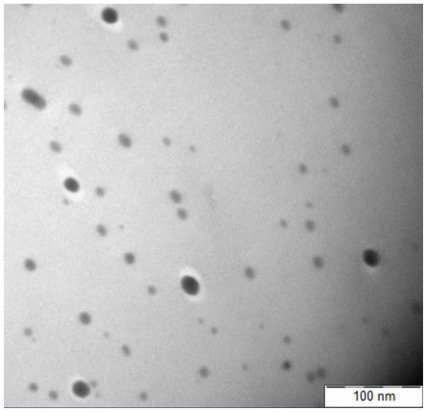
TEM micrograph of PCL/chitosan/1 wt% CaCO3 nanoparticles.